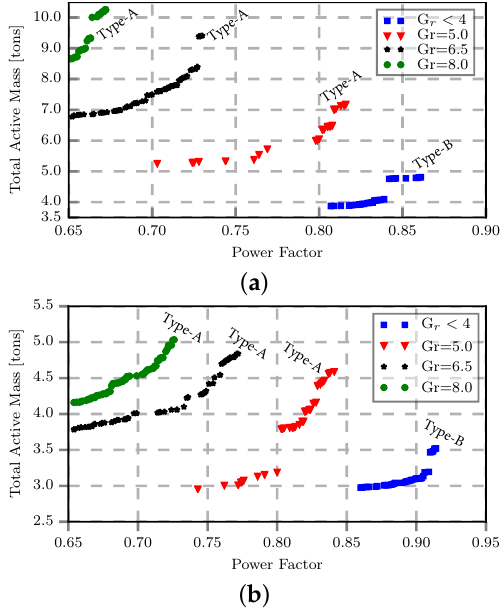
Figure 13. A 1MW PMVM’s active mass vs. power factor: ( a ) 30Hz ( b ) 60Hz (©[2020] IEEE. Reprinted, with permission from